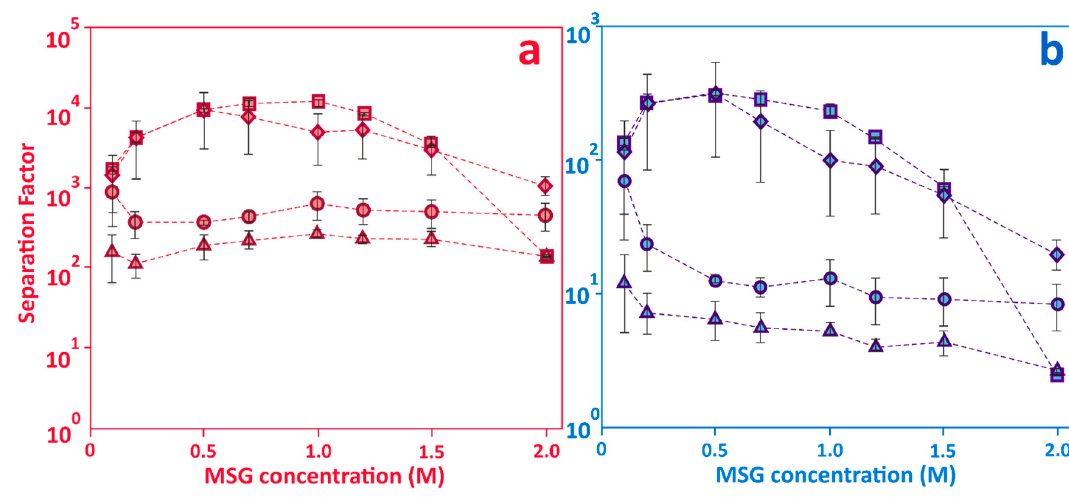
Figure 6. The recovery of ( a ) Zn, Cu, Mg, Ca and Fe and ( b ) Al as function of MSG concentration.